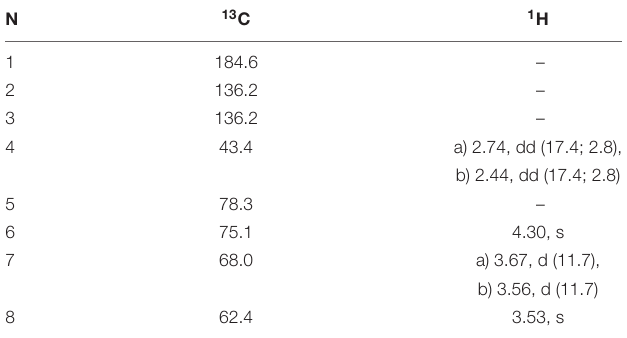
TABLE 5 | 1 H and 13 C NMR chemical shifts (in ppm) and proton coupling constants (Hz, in parentheses) of Gadusol isolated from the terrestrial green alga Klebsormidium crenulatum